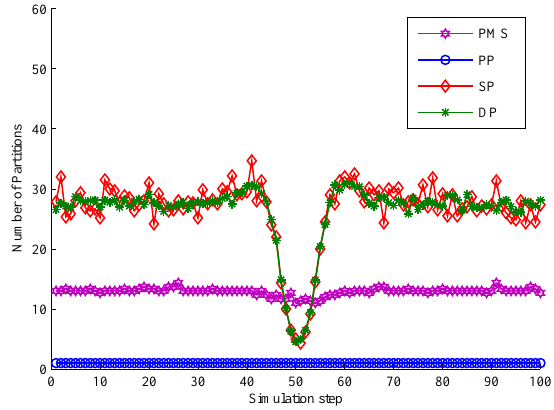
Figure 16. The comparison of four approaches in partitioning